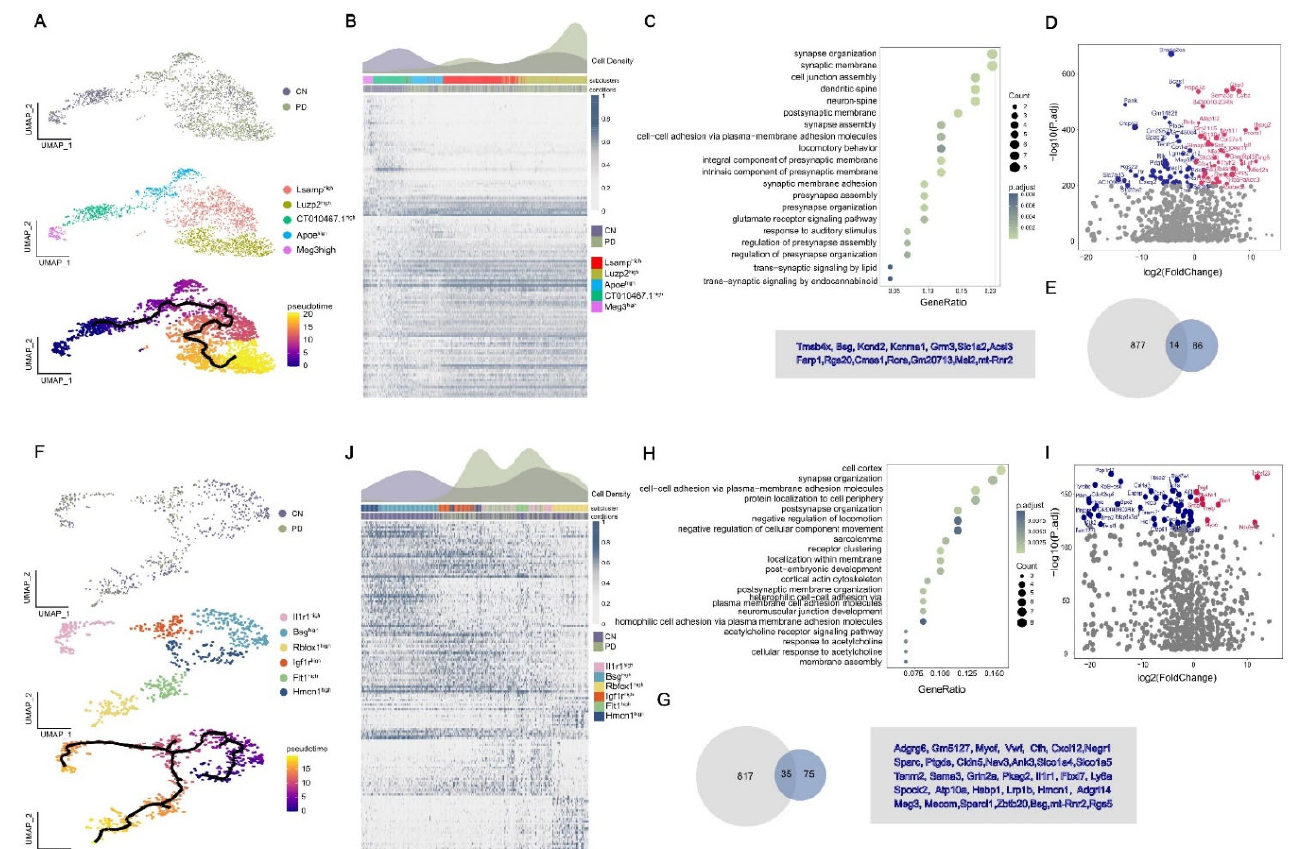
Figure 3. Trajectory reconstruction reveals astrocyte and endothelial differential activation in PD. ( A , F ) AST1 and ENDO subclusters labeled with a representative marker gene and trajectory recon ‐ struction and pseudotime representation of subclusters. ( B , J ) PD and CN differential cell density distribution along pseudotime. The expression of 100 and 113 genes highly associated with the AST1 and ENDO activation trajectory, respectively. ( C , H ) KEGG and GO terms associated with genes of the Luzp2 High and Lsamp High cells in AST1 and Hmcn1 High , Igf1r High , Flt1 High in ENDO, respectively. ( D , I ) Volcano map of DEGs in PD and CN. The up ‐ regulated genes with red dots, down ‐ regulated genes with blue dots. ( E , G ) The overlapped genes between PD ‐ DEGs and the DEGs along the AST1 and ENDO activation trajectory.